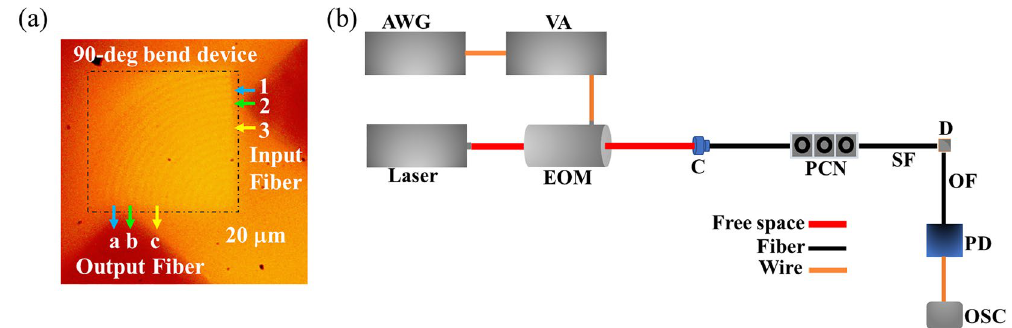
Figure 5. Prototype testing for specific SVPC applications. The objects are not drawn to scale. ( a ) Microscope image of the prototype SVPC with optical fibers for measuring crosstalk. Both fibers are single-mode optical fibers with tapered tips; the numbers and letters indicate the positions of the optical fibers. ( b ) Schematic of experimental setup for demonstrating application of the SVPC with a pulse signal (AWG: Arbitrary